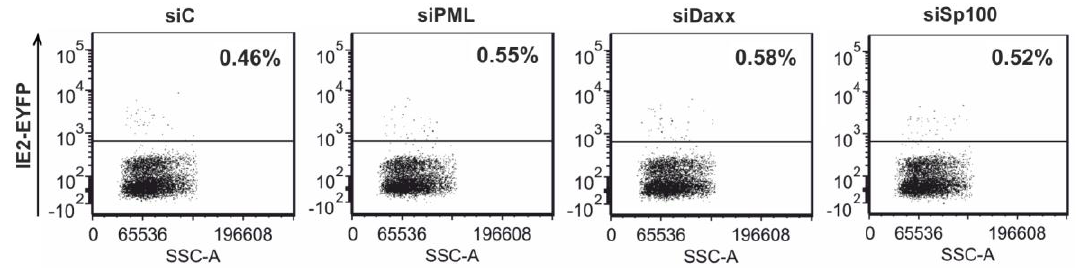
Figure 7. Similar numbers of IE2-EYFP positive cells in PML-kd, hDaxx-kd, Sp100-kd and control THP-1 monocytes after infection of these cells with TB40E/IE2-EYFP at an MOI of 4. At 24 hpi, cells were harvested and IE2-EYFP expression was analyzed by flow cytometry.